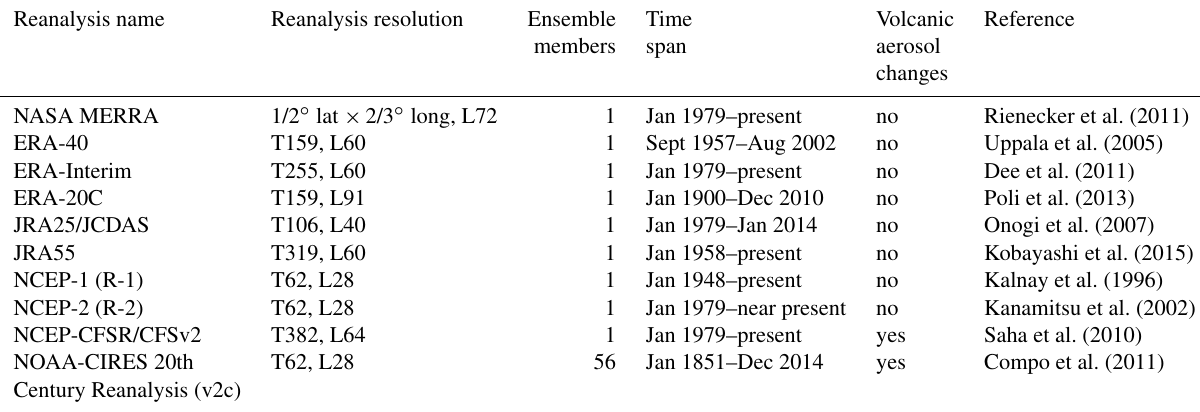
Table 1. Reanalysis products used in this